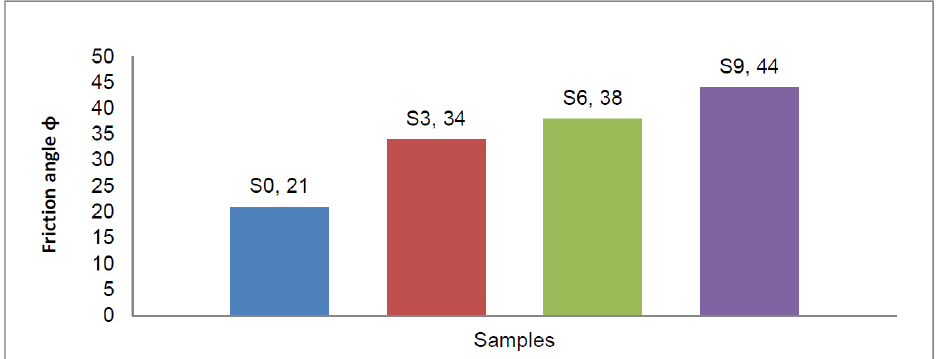
Figure 24. Effects of lime and cement dust on friction angle of swelling soil.